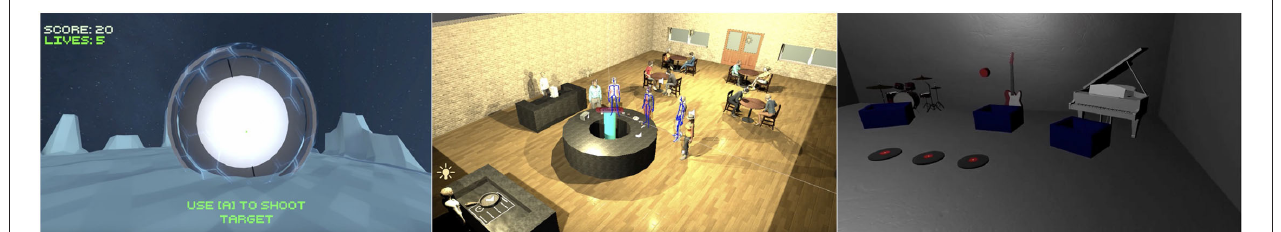
FIGURE 3 | (Left) Localisation game. (Middle) Speech-in-noise game. (Right) Music training game.